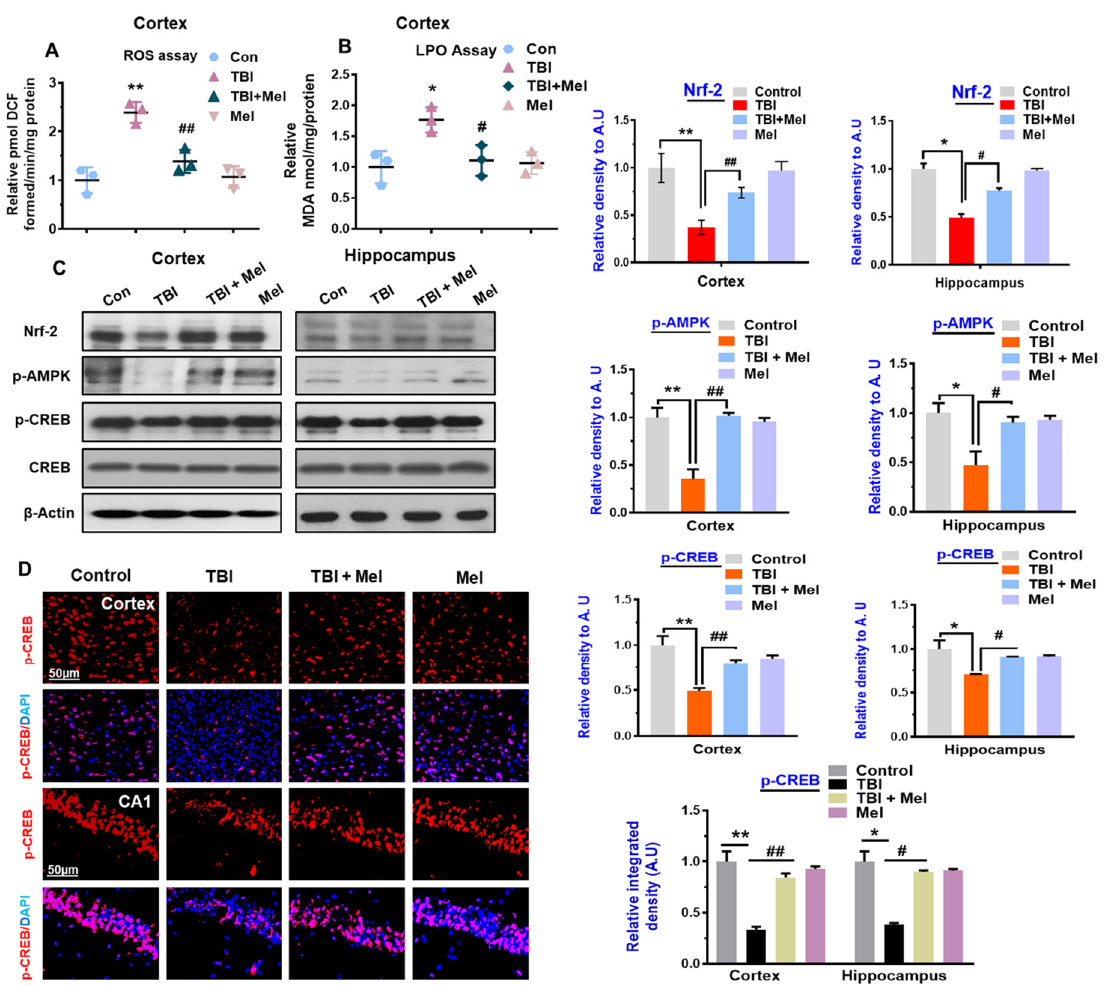
Figure 1. Melatonin treatment reduces oxidative stress and regulates the expression of Nrf-2, p-AMPK, and p-CREB in the repetitive mild traumatic brain injury (rmTBI)-mouse model. ( A ) Representative histogram showing the reactive oxygen species (ROS) level among the treated mice group ( n = 3). ( B ). Shown is the histogram of the lipid peroxidation among the treated mice group ( n = 3). ( C ). Western blot analysis and histogram showing expression levels of the Nrf-2, p-AMPK, and p-CREB in the ipsilateral cortex and hippocampus of the rmTBI and rmTBI plus melatonin (Mel)-treated group on day 7. n = 10 mice per group. All the values were normalized with beta-actin. Protein bands were quantified with SigmaGel software. ( D ) Confocal microscopic results of p-CREB expressions in the di ff erent experimental groups, with respective bar graphs. n = 5 mice per group. Magnification 10x. The confocal image’s data was taken from three independent experiments. Di ff erences have been shown in the graphs. The confocal images were analyzed through ImageJ software. The values are expressed as mean ± SEM: One-way ANOVA followed by post-hoc analysis. * p < 0.05 and ** p < 0.01 represent di ff erence between control and rmTBI, and # p < 0.05 and ## p < 0.01 represent di ff erence between rmTBI plus Mel-treated group.